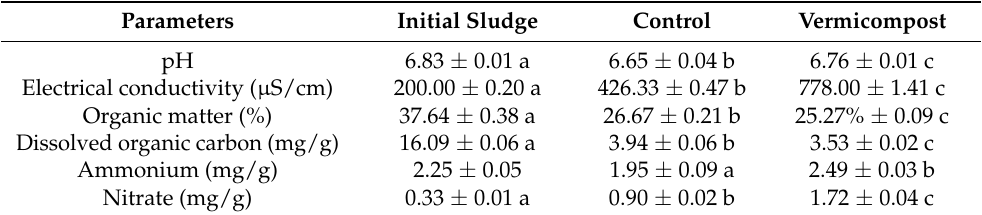
Table 1. Physicochemical properties of raw sludge and final sludge products of vermicompost and control. Parameters